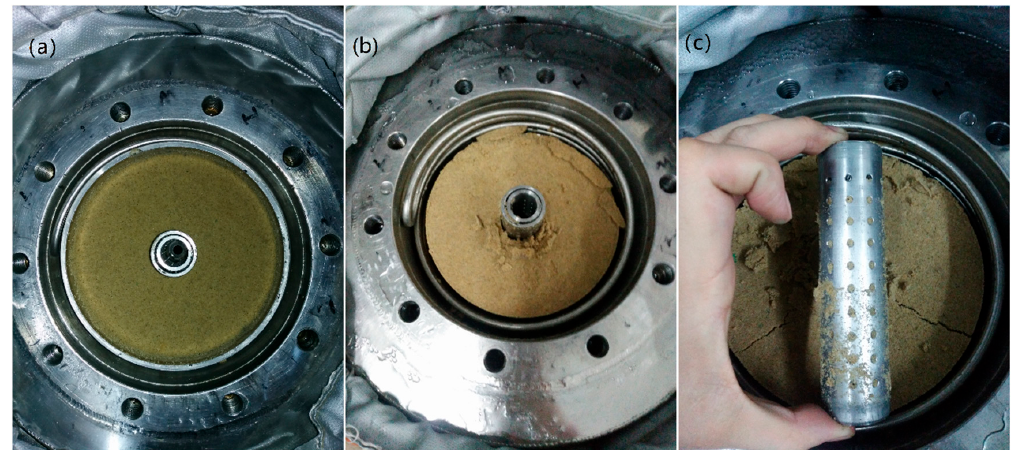
Figure 3. Images of experiments: ( a ) initial sediments; ( b ) end production; ( c ) produced liner with screen.